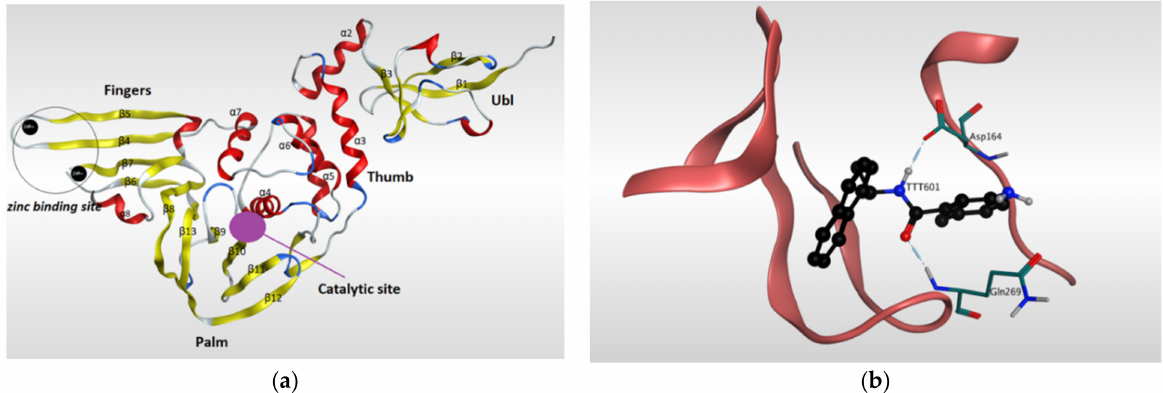
Figure 5. Ribbon representation of Papain-like protease of SARS-CoV-2. ( a ) Ribbon representation of the structure of Papain-like protease of SARS-CoV-2 (PDB: 7CMD ) in its open conformation after removal of the ligand. It illustrates the four subdomains of the enzyme: N-terminal ubiquitin-like domain (Ubl, β 1-3), α -helical Thumb domain ( α 2-7), β - stranded Finger domain ( β 4-7), and Palm domain ( β 8-13). B-sheets are colored in yellow, while α -helices are colored in red. ( b ) Ribbon representation of liganded Papain-like protease of SARS-CoV-2 (PDB: 7CMD ) with GRL0617 and its interaction with the